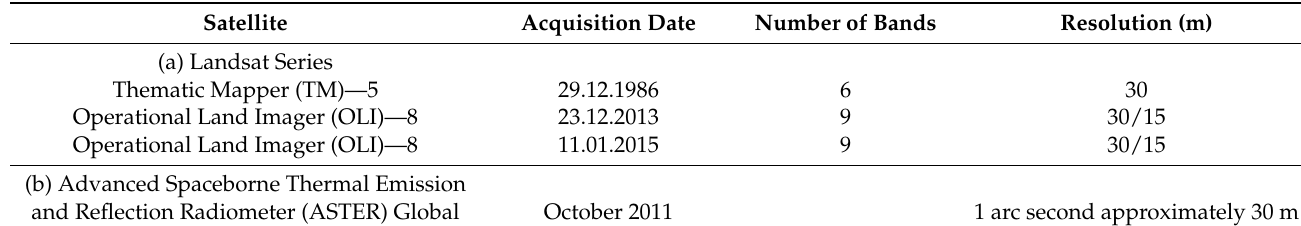
Table 1. Raster Data used in this study.